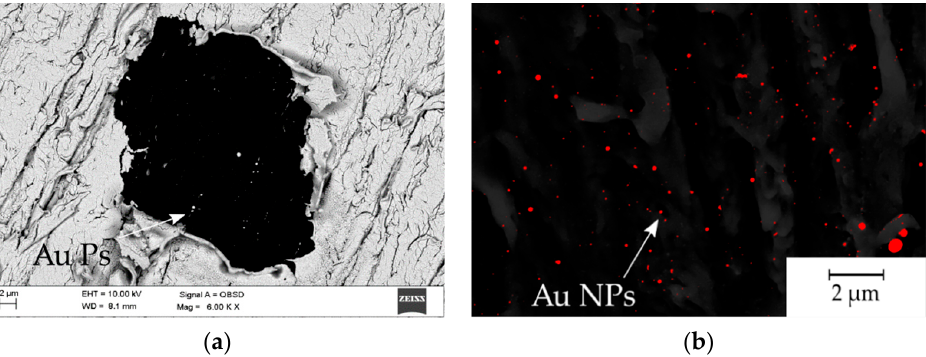
Figure 7. SEM images prepared for the statistical analysis of particle distribution: ( a ) 4.5 mW single laser irradiation spot, SEM, QBSD; ( b ) SEM, SE+QBSD image threshold to quantitative analysis of the Au particles.